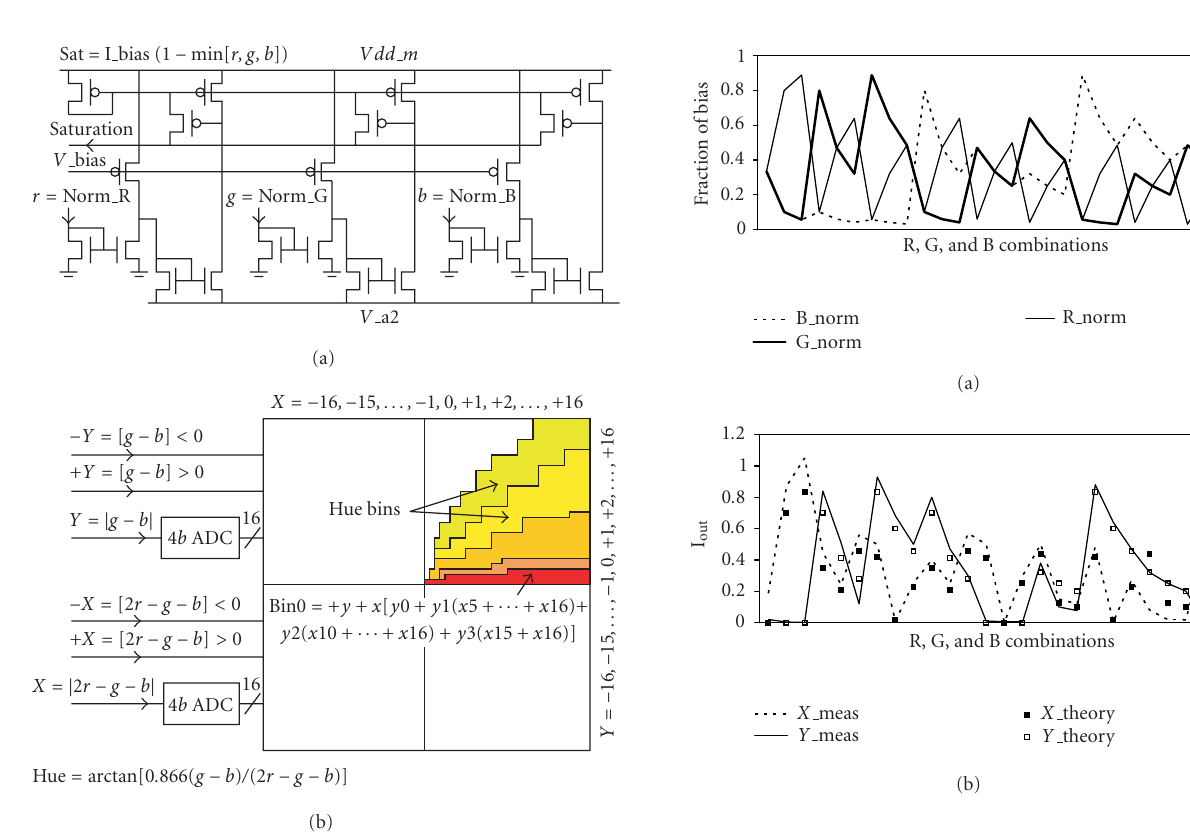
cuit’s output mirror, while the o ff set on the right side of the saturation curve is caused by a layout property that reduced Vdd for one part of the circuit. Consequently, the satura- tion current is higher than expected when the r component is